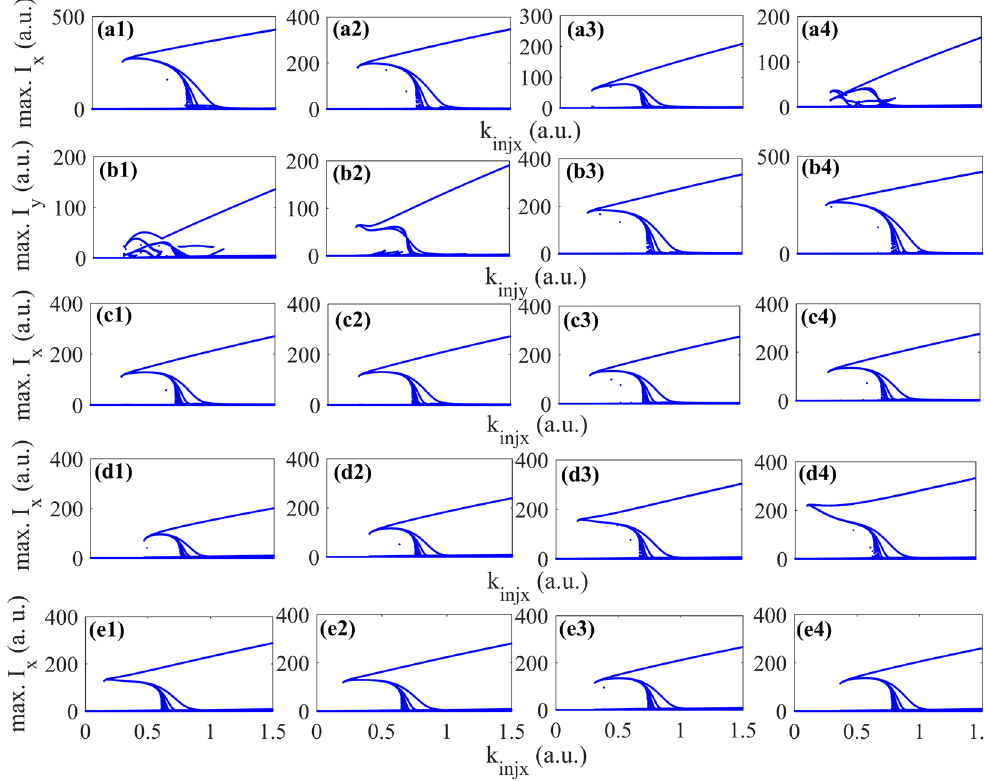
Figure 4. Numberical bifurcation diagrams as a function of k injx under different cases of ε a in XP mode ( a1 )– ( a4 ), ε a in YP mode ( b1 )–( b4 ), ε p in XP mode ( c1 )–( c4 ), μ 1 in XP mode ( d1 )–( d4 ) and μ 2 in XP mode ( e1 )– ( e4 ). ( a1 )–( a4 ), ( b1 )–( b4 ) corresponding to ε a = − 0.1, − 0.05, 0.05 and 0.1, ( c1 )–( c4 ) corresponding to γ p = 9, 12, 18 and 21 ns − 1 , ( d1 )–( d4 ) corresponding to μ 1 = 1.9, 2.0, 2.2 and 2.3, ( e1 )–( e4 ) corresponding to μ 2 = − 5.7, − 5.9, − 6.3 and −